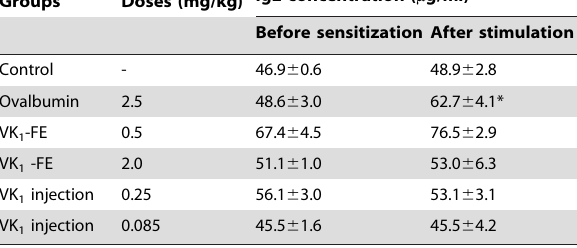
Table 7. The change in plasma IgE concentrations after the challenge with vitamin K 1 (VK 1 ) injection and vitamin K 1 -fat emulsion (VK 1 -FE).